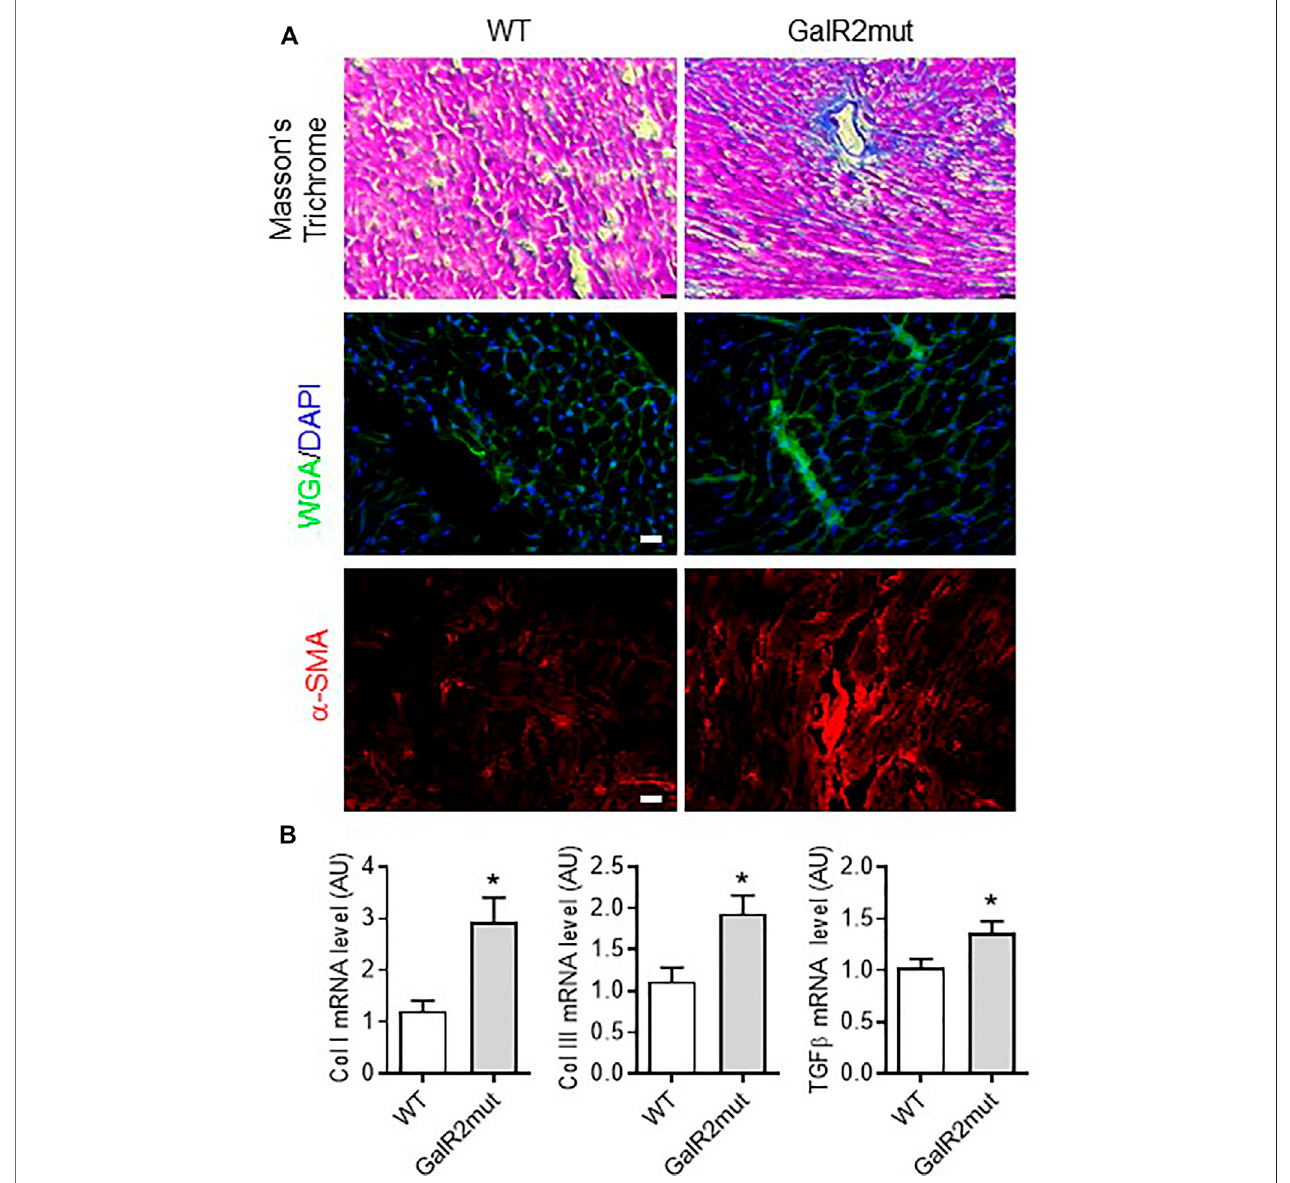
FIGURE 4 | Cardiac fi brotic remodeling in GalR2 mutant mice. (A) Representative images of Masson ’ s Trichrome, WGA- or α -SMA immunolabelling or staining to depict fi brotic remodeling in GalR2mut hearts. (B) Myocardial mRNA levels of pro fi brotic factors Col I, Col III and TGF β in WT and GalR2mut mice, n = 5 – 10. Data represents the mean ± SEM. * p < 0.05 vs.